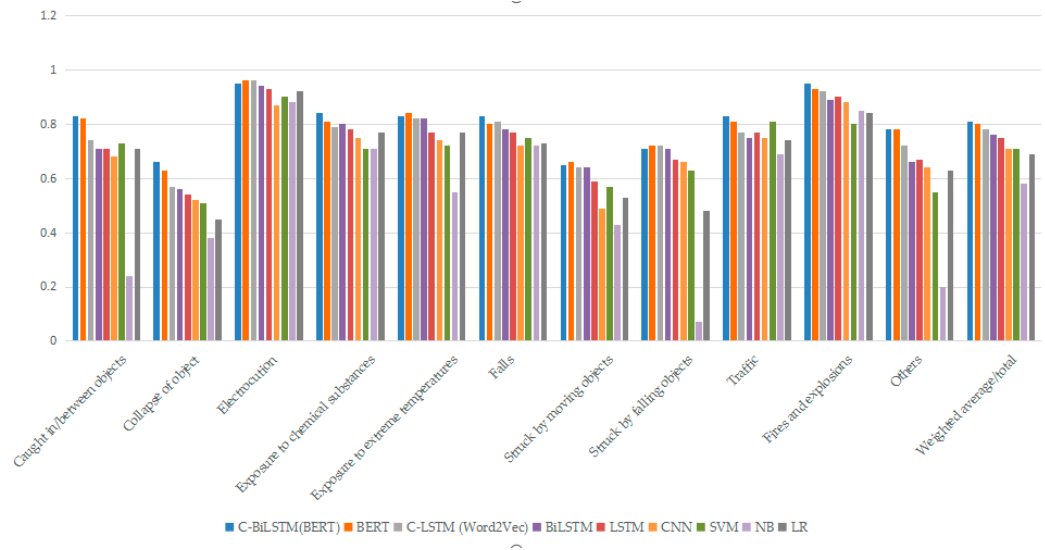
Figure 6. F1 scores of different methods.